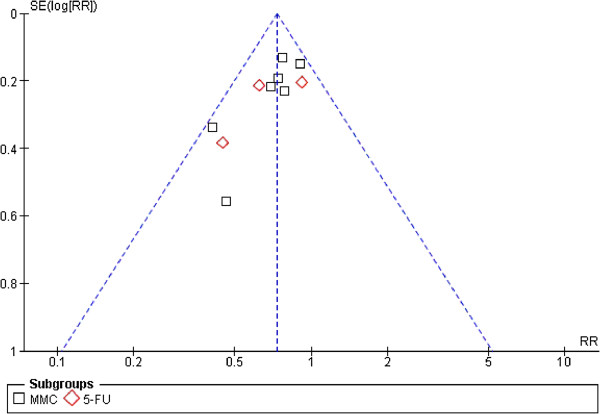
Funnel plot analysis of potential publication bias.